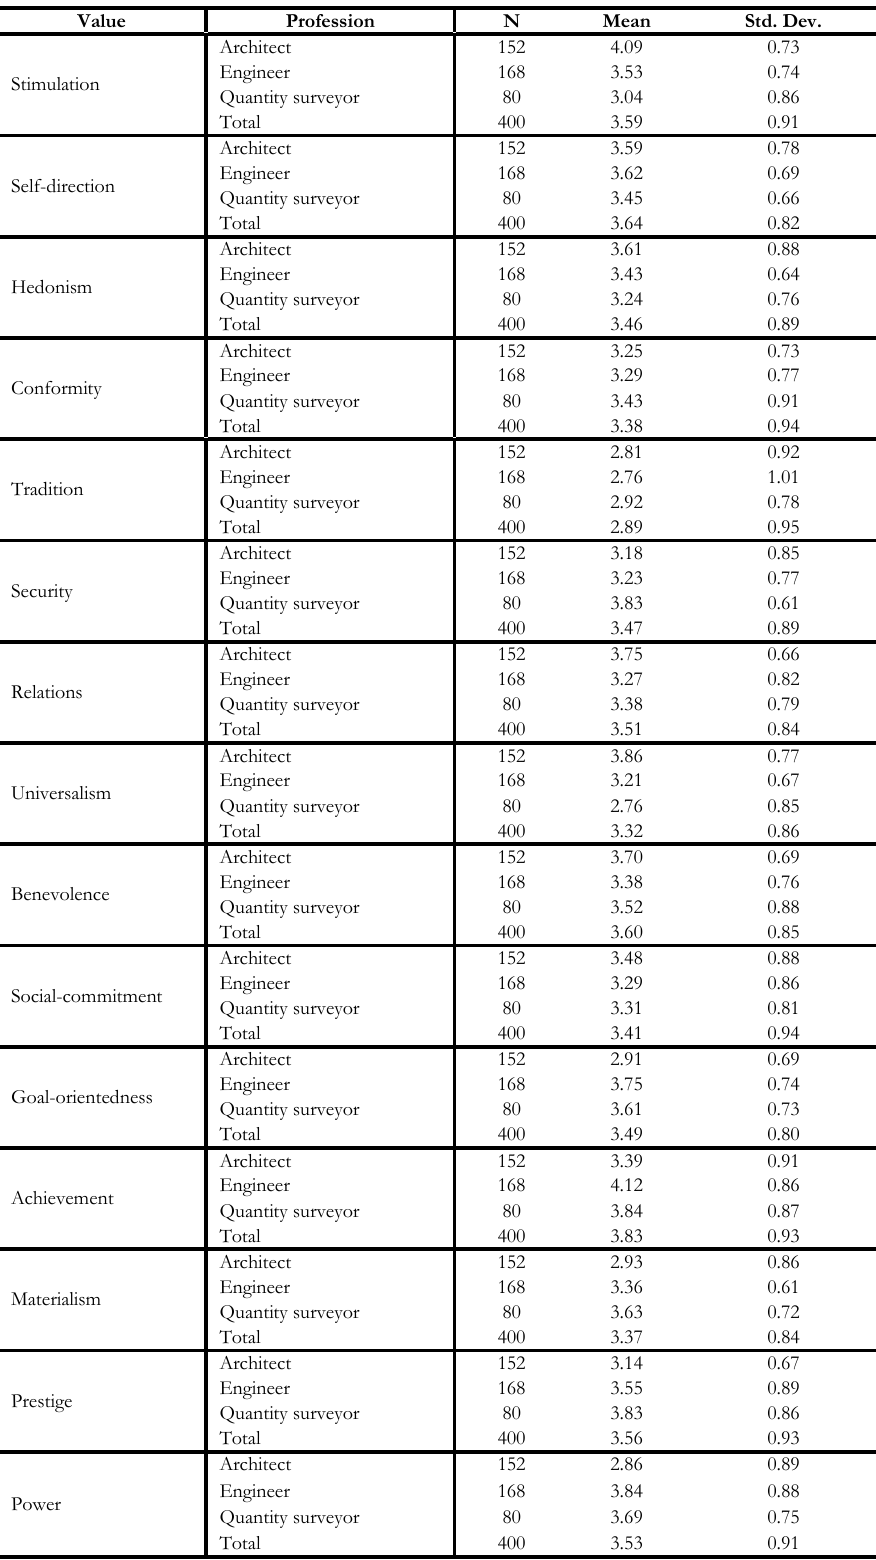
Table 3: Descriptive statistics of the 15 value